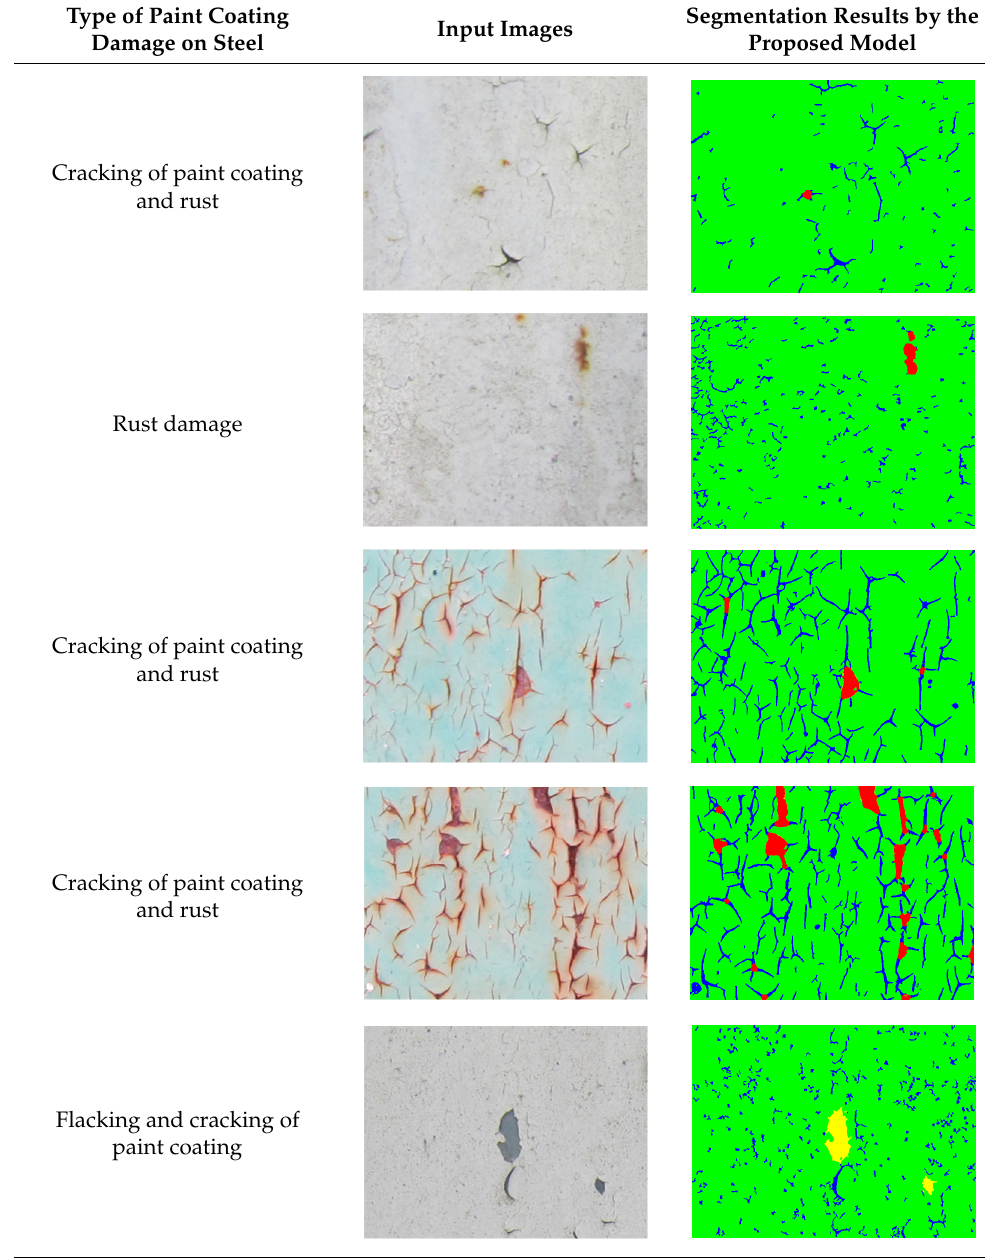
Table 3. Results of paint damage and rust segmentation.